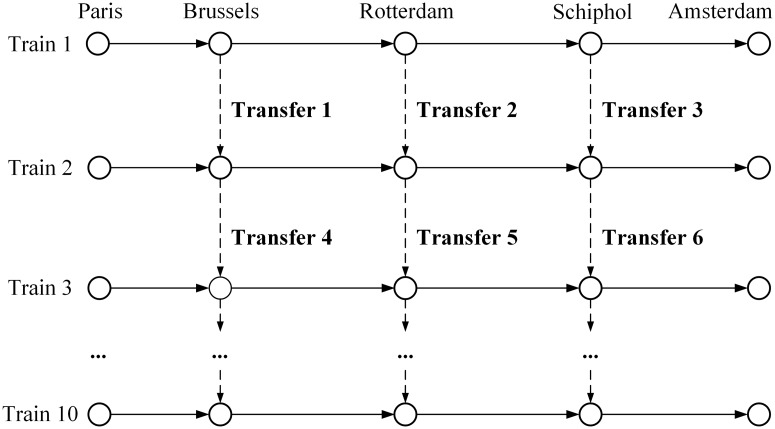
Available transfers.